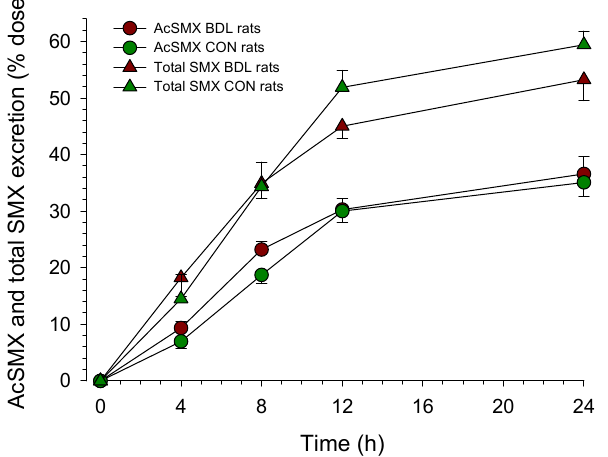
Figure 3. Urinary excretion of N-acetyl-sulfamethoxazole (AcSMX) after the administration of sulfamethoxazole (SMX). Rats were bile duct ligated for 4 weeks (BDL rats, n = 9) or sham-operated control rats ( n = 5). After the i.p. administration of 10 mg of SMX per 100 g body weight, urine was collected in individual portions from 0 to 4 h, 4 to 8 h, 8 to 12 h, and 12 to 24 h. The SMX and AcSMX concentrations in urine were determined by HPLC, as described in Methods. Data are presented as mean ± SEM.